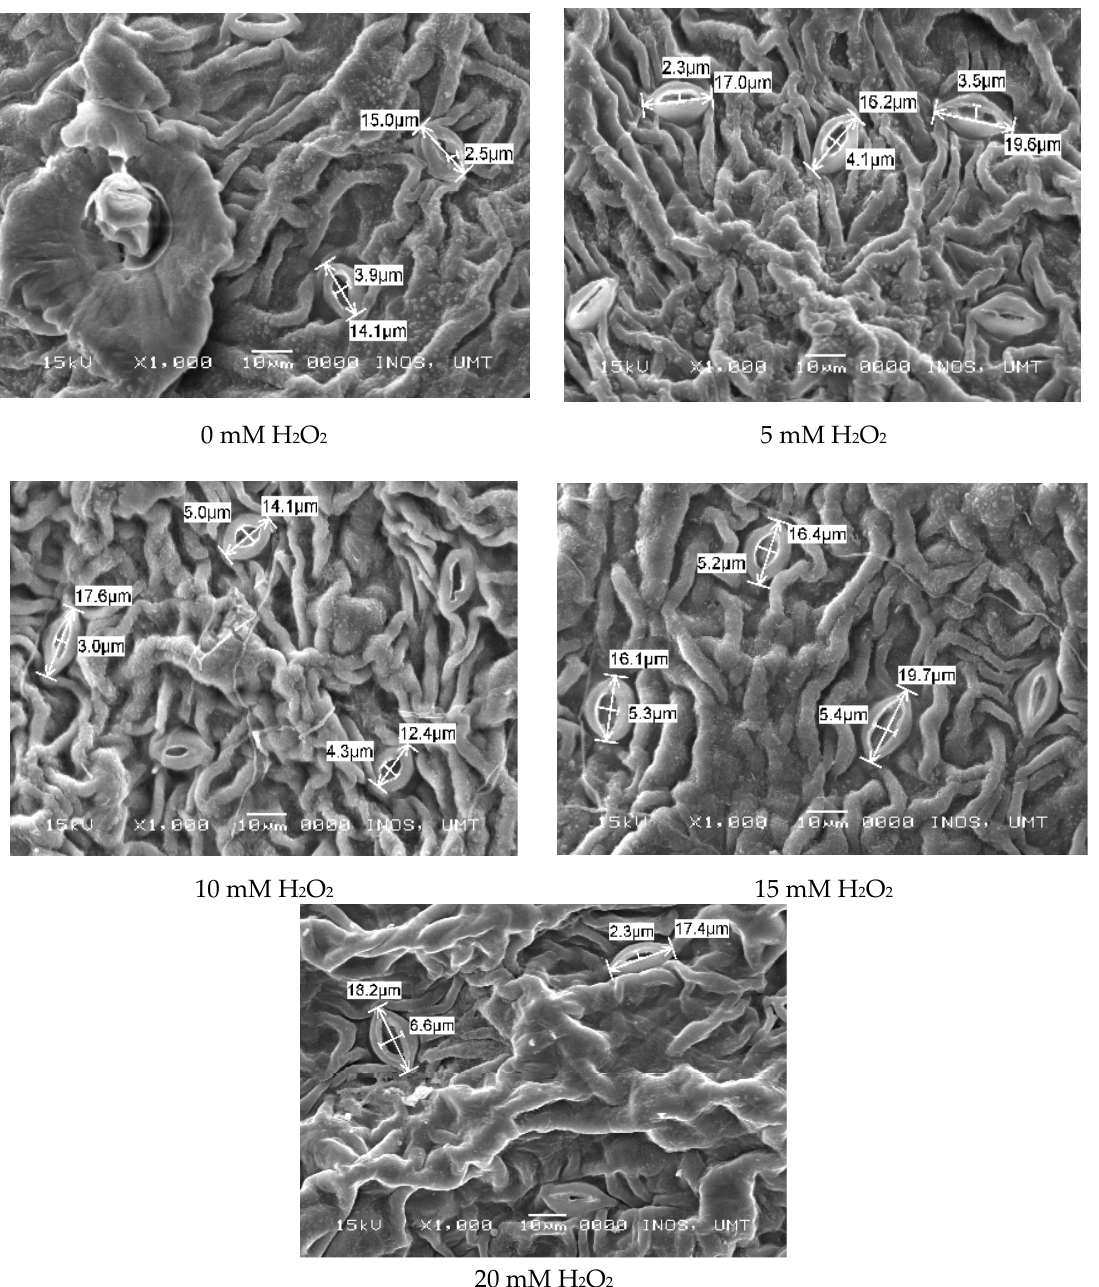
Figure 2. SEM photographs showing the stomatal closure at upper surface of the treated and untreated leaves Ficus deltoidea var. deltoidea plant.